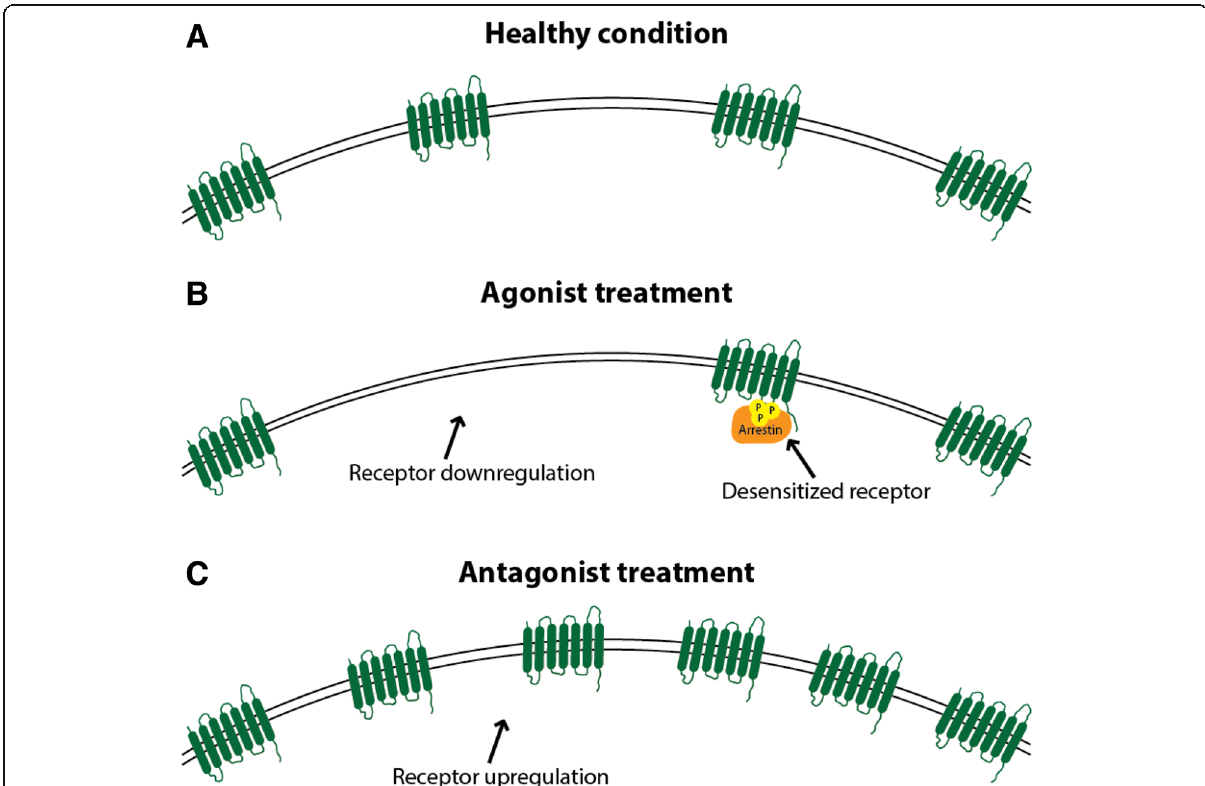
Fig. 1 Schematic representation of potential receptor expression changes upon chronic drug use. Receptor expression in the cell membrane in healthy condition ( a ), after prolonged agonist exposure ( b ), and after prolonged antagonist exposure ( c ). After prolonged agonist exposure, downregulation and desensitization (by arrestin binding after phosphorylation by GPCR Kinase) could occur. After prolonged antagonist exposure, receptor upregulation is expected to take